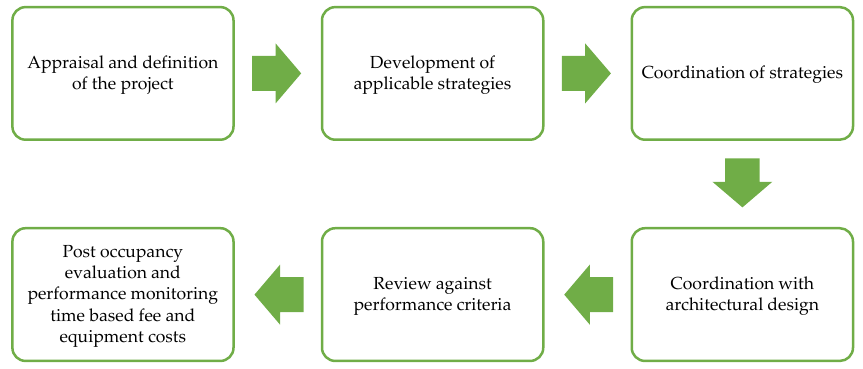
Figure 6. Methods for each stage of the project life cycle.